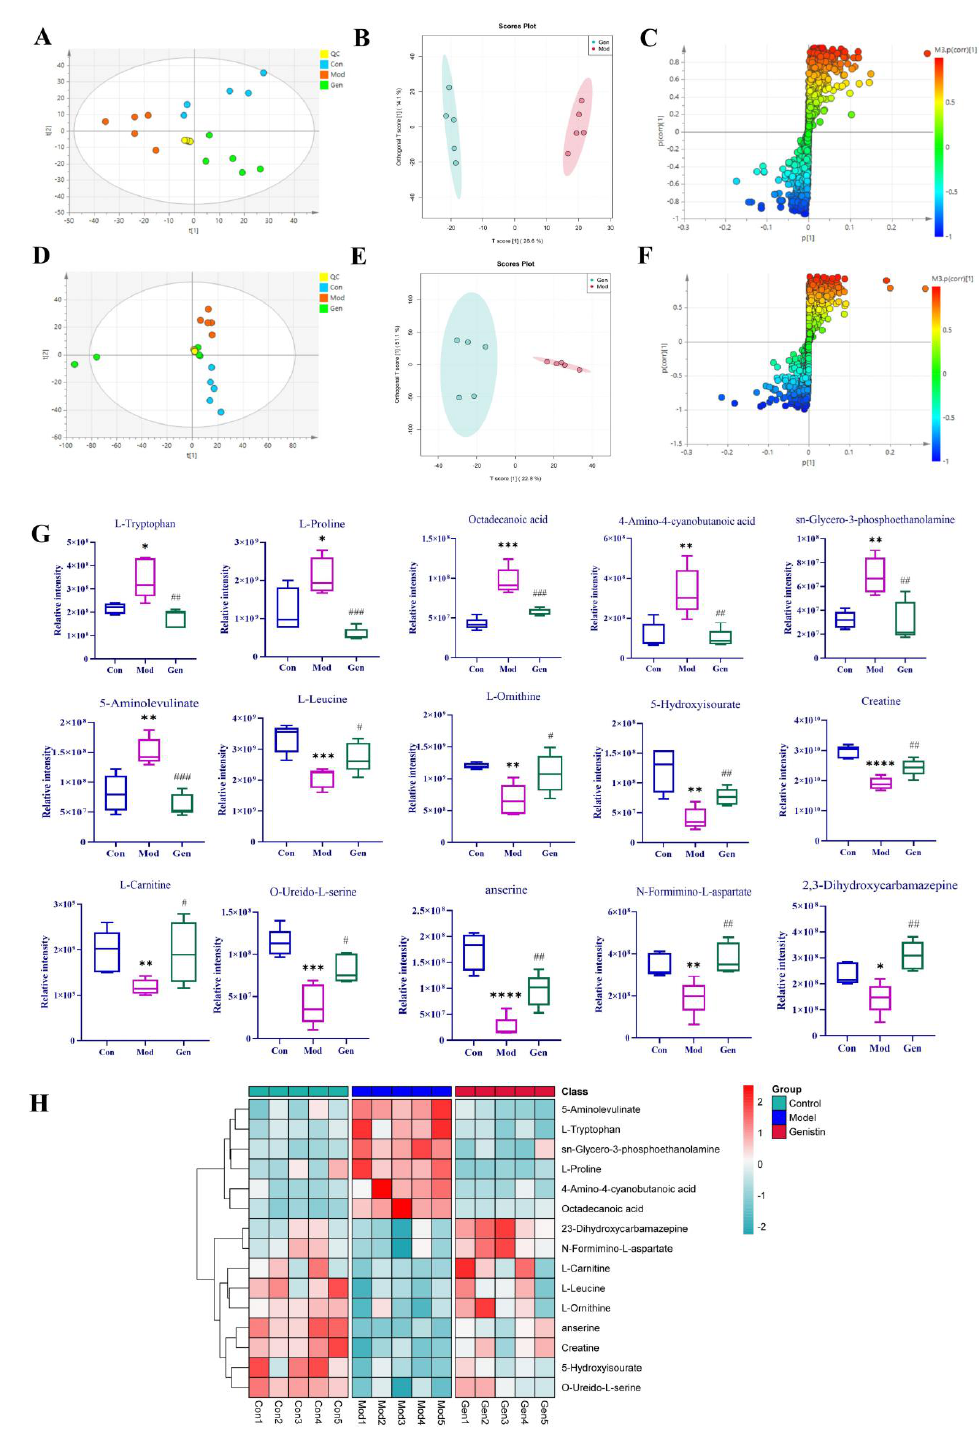
Figure 4. The effects of genistin on metabolic parameters in hyperlipidemic rats and correlation analysis. ( A ) Negative PCA score plot. ( B ) Negative OPLS-DA plots (R2X = 0.424, R2Y = 0.989, Q2 = 0.869). ( C ) Negative S-plots. ( D ) Positive PCA score plot. ( E ) Positive OPLS-DA plots (R2X = 0.458, R2Y = 0.984, Q2 = 0.875). ( F ) Positive S-plots. ( G ) Results of 15 differential metabolites vs Gen, Con, and Mod. ( H ) Heat map of the differential metabolites in the plasma of rats (Red and blue represent increased and decreased metabolite content, respectively). Gen: genistin high dose treatment group. * p < 0.05, ** p < 0.01, *** p < 0.001, and **** p < 0.0001, Con vs Mod; # p < 0.05, ## p < 0.01, and ### p < 0.001, Gen vs Mod.